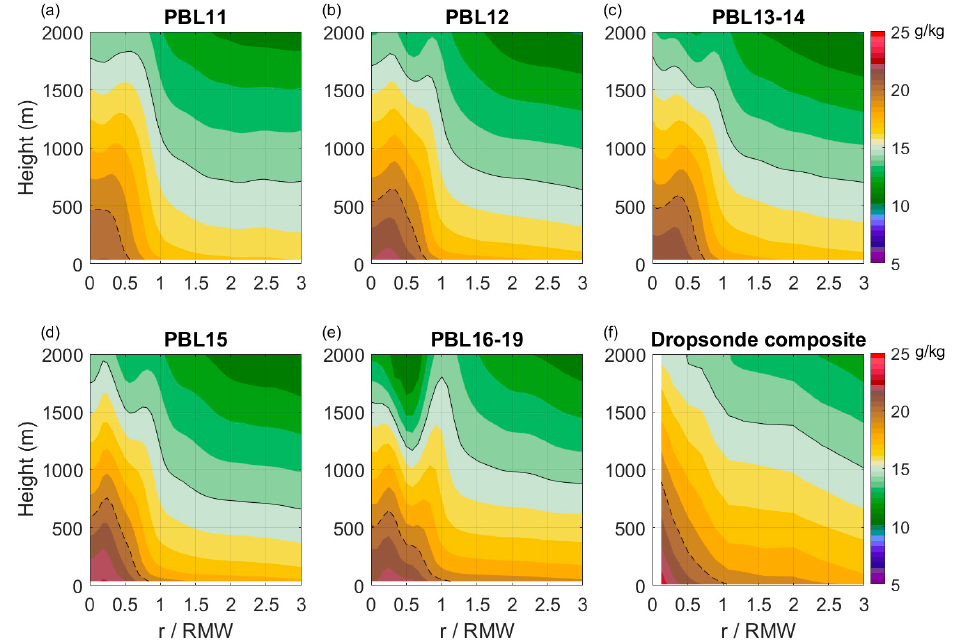
Figure 10. Normalized radius-height plot of azimuthally averaged specific humidity ( < q > ) over t = 84–108 h in the idealized HWRF simulations with ( a ) PBL11, ( b ) PBL12, ( c ) PBL13–14, ( d ) PBL15, and ( e ) PBL16–19 schemes. The dropsonde composite of ( < q > ) is shown in ( f ). The black solid and dashed lines are the 15 g / kg and 20 g / kg contours, respectively. RMW is the radius of the maximum wind speed.